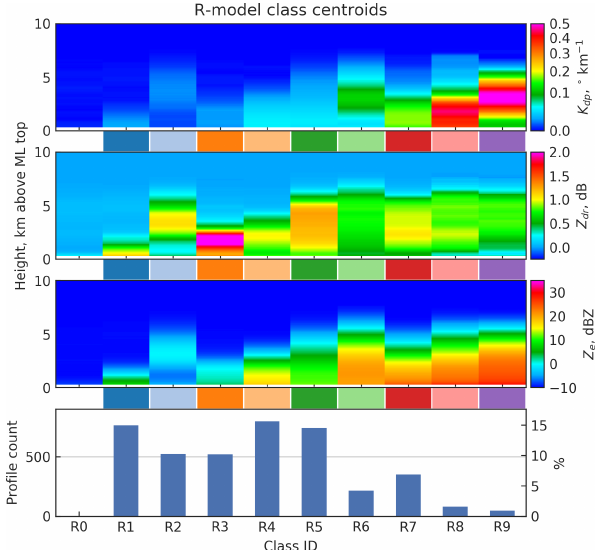
Figure 2. Class centroid profiles of the R model. Profile counts per class are shown at the bottom omitting the count for low-reflectivity class R0. Between the panes, each class has been assigned a color